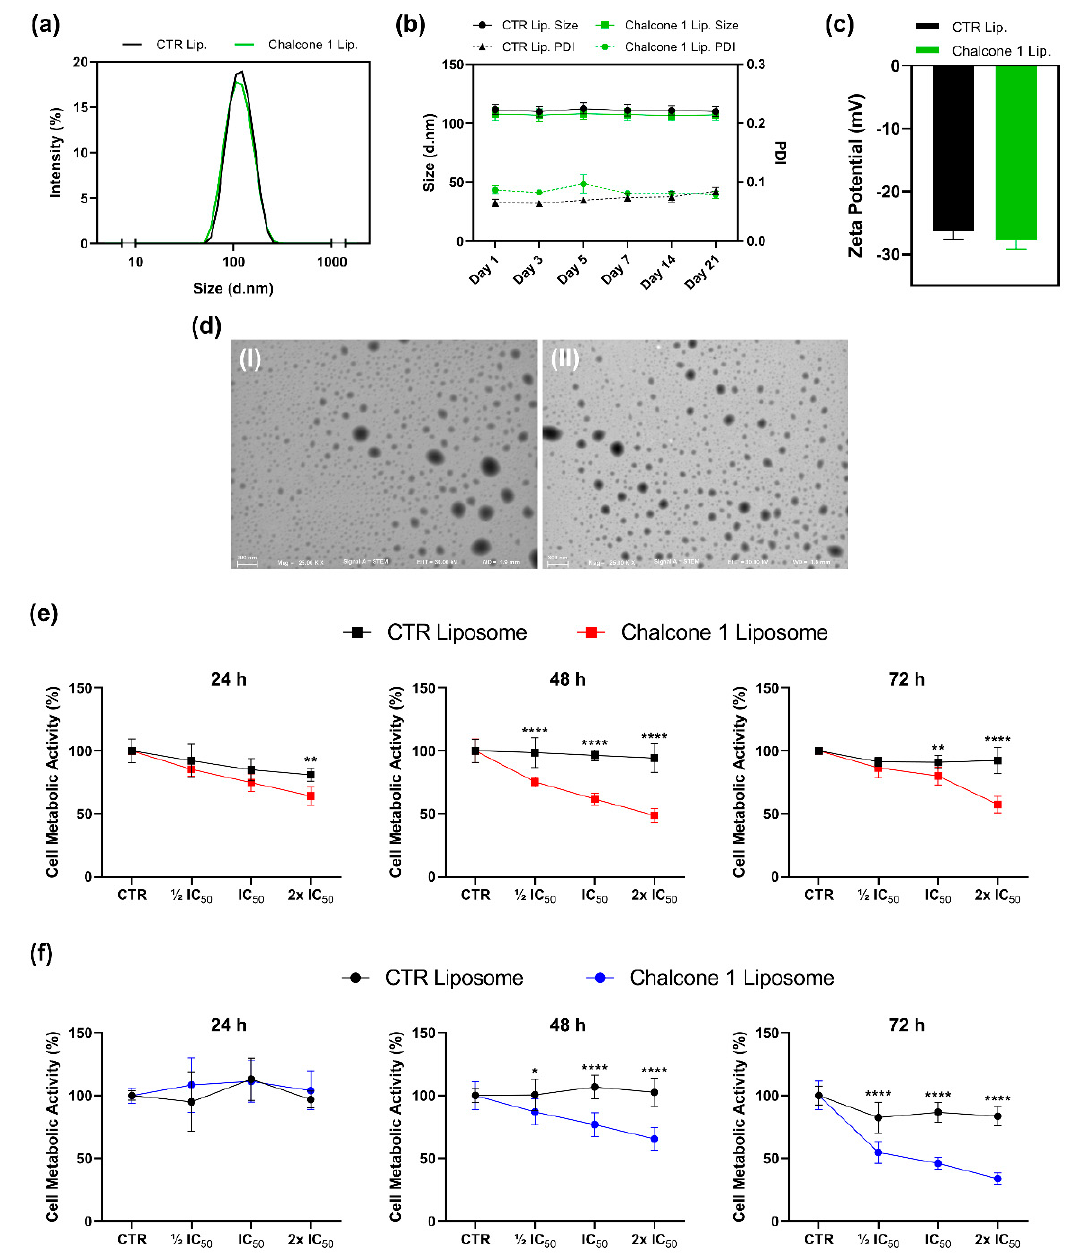
Figure 6. Characterization and biological activity of liposomes incorporating chalcone 1 . Analyses of the size distribution ( a ), stability ( b ), and zeta potential ( c ) of liposomes. Morphological analyses of empty liposomes (I) and liposomes incorporating chalcone 1 (II) by STEM ( d ). U87 ( e ) and GL261 ( f ) GBM cells metabolic activity was quantified by MTS assay in the absence (control—CTR) and presence of liposomes incorporating chalcone 1 at concentrations of ½ IC50, IC50, and 2x IC50 at the different time points. Results are presented as mean ± SD of three independent experiments. * p < 0.05, ** p < 0.01, **** p < 0.0001 compared to CTR.